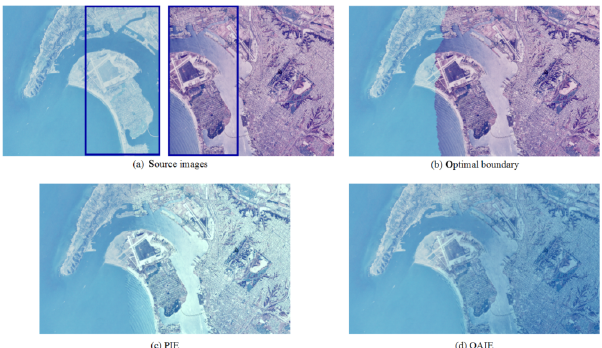
Fig. 6 Seamless stitching two remote sensing images with very large tone difference. Optimal seam methods lead to obvious artifacts due to the color difference between source images. The PIE result contains inconsistent textures while OAIE achieves a more globally natural